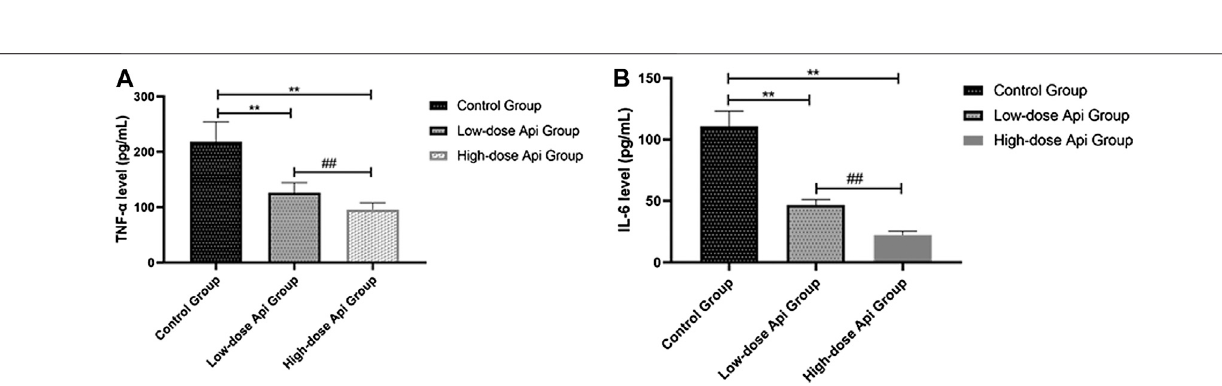
Frontiers in Pharmacology |